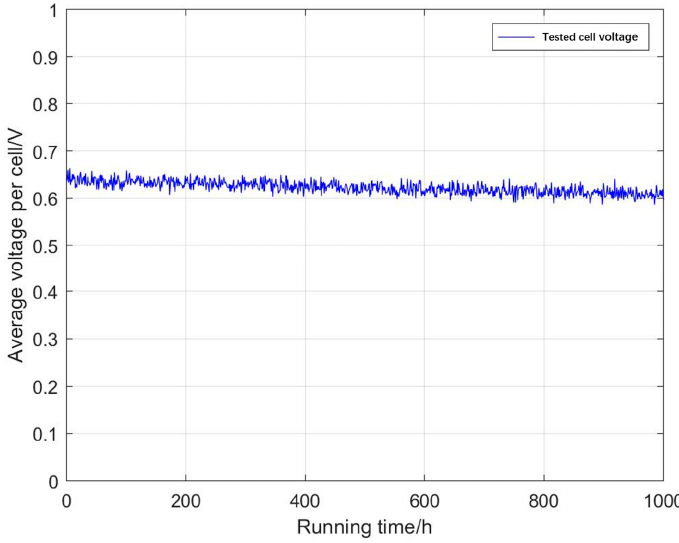
Figure 1. Fuel cell degradation under rated current.